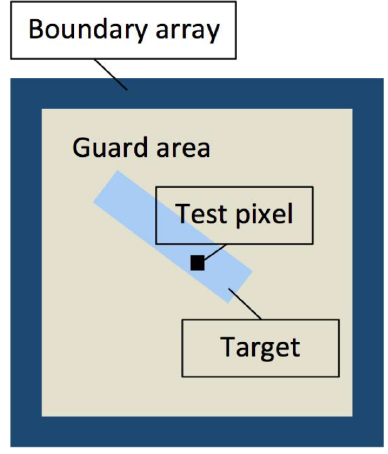
Figure 3. CFAR detector moving